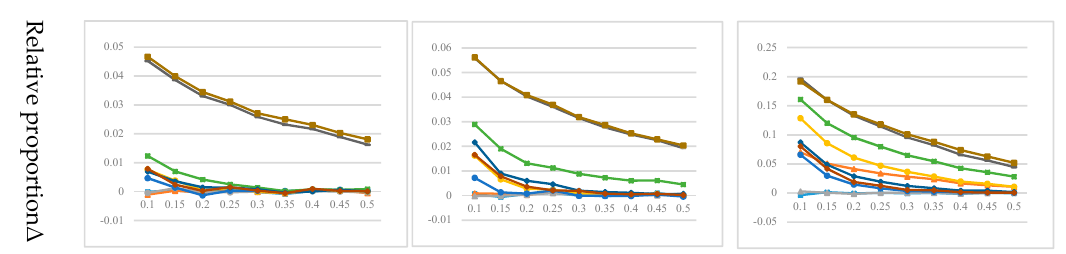
Figure 6. In full-contact SIR model, the relationship between Δ and β . with 3% nodes in key node- set.